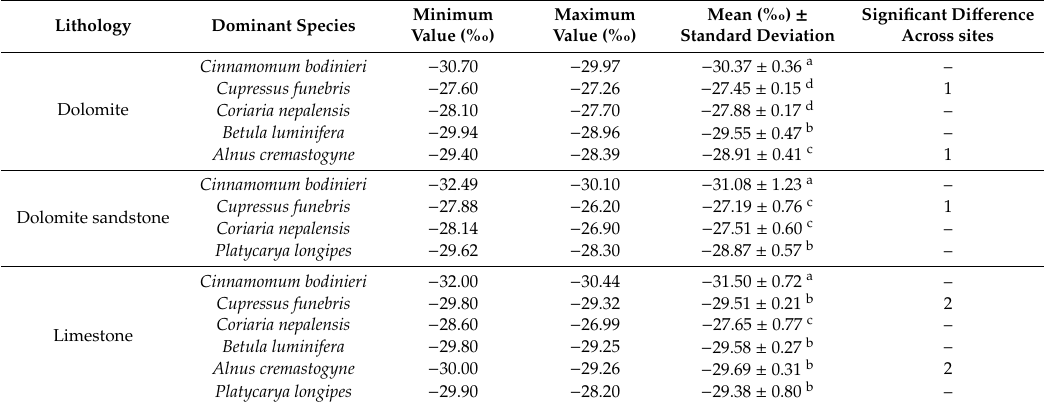
Table 1. Characteristics of the δ 13 C values of the dominant species in three lithological soil